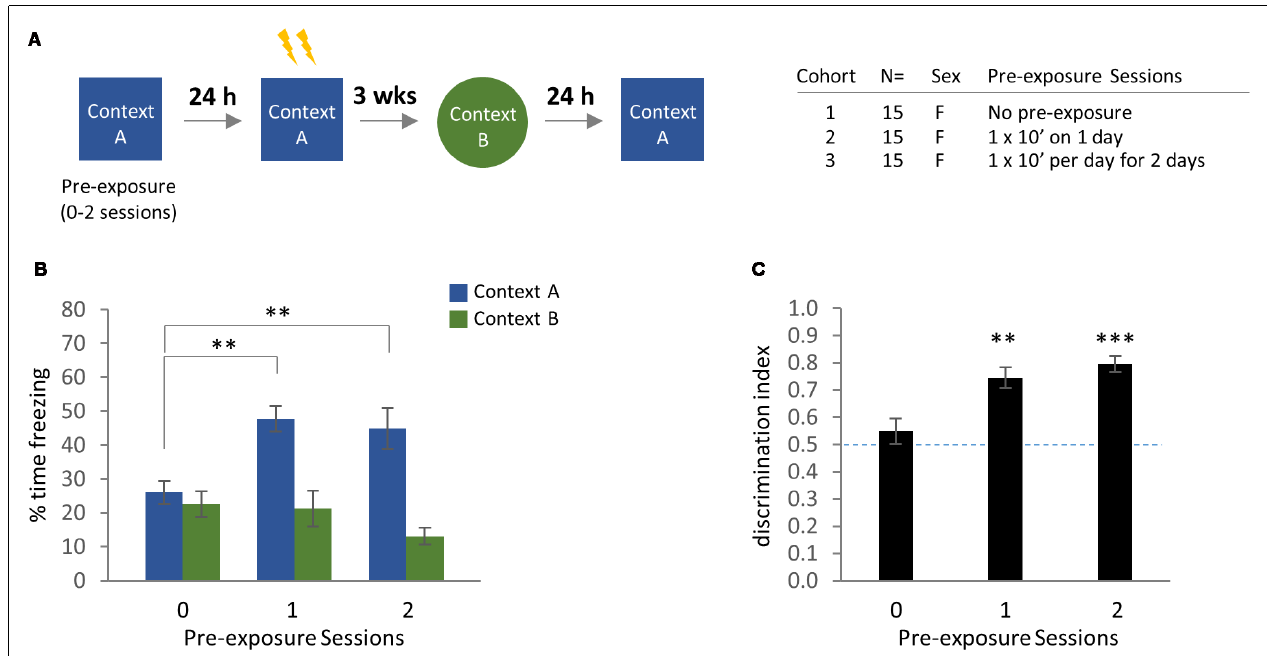
FIGURE 5 | Effect of context pre-exposure (0–2 sessions) on remote contextual fear generalization using distinct training and generalization contexts. (A) Experimental design. N = 30 mice per test order (AB or BA), with 15 mice for each pre-exposure condition. (B) Effect of test order on freezing behavior in the training context vs. novel context. Significant Bonferroni post hoc comparisons following two-way ANOVA are indicated. (C) Discrimination index calculations from previous data. Significant Bonferroni post hoc comparisons following one-way ANOVA are shown in graph. Dotted line indicates no-discrimination threshold. ∗∗ p < 0.01, ∗∗∗ p < 0.001. Error bars are mean ± SEM.